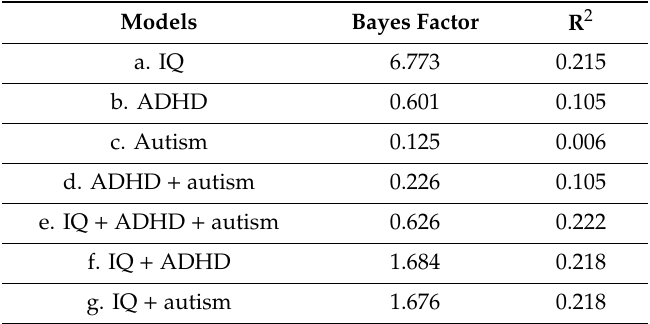
Table 3. Results of the Bayesian linear regression on relative alpha reactivity, investigating the predictive e ff ect of IQ, ADHD-, and